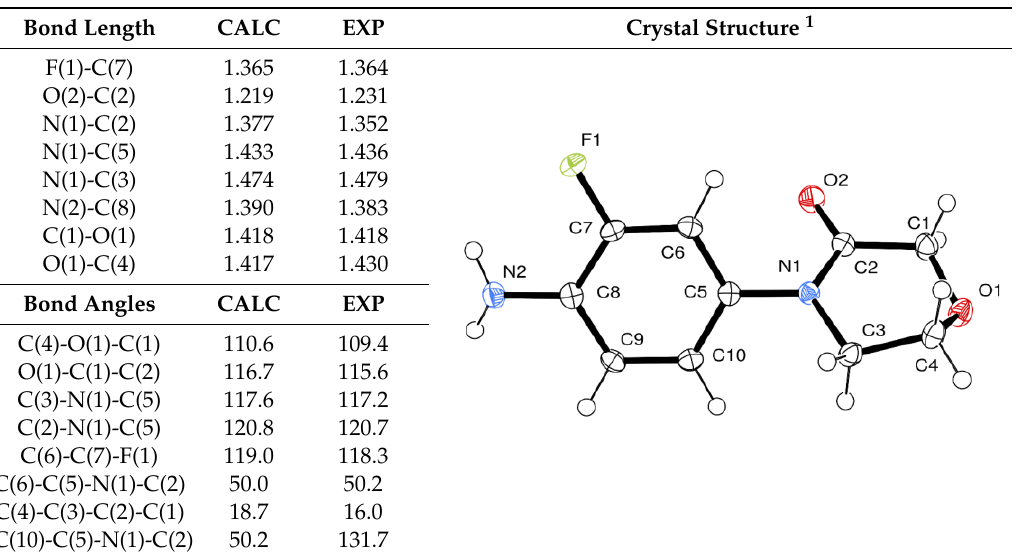
Table 6. Selected bond lengths and angles for molecule 9 .